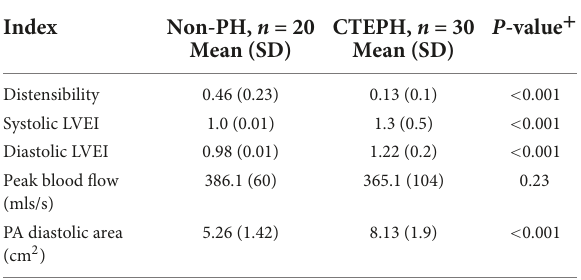
TABLE 3 Novel measurements by cardiac MRI in patients with chronic thromboembolic pulmonary hypertension vs. those without.